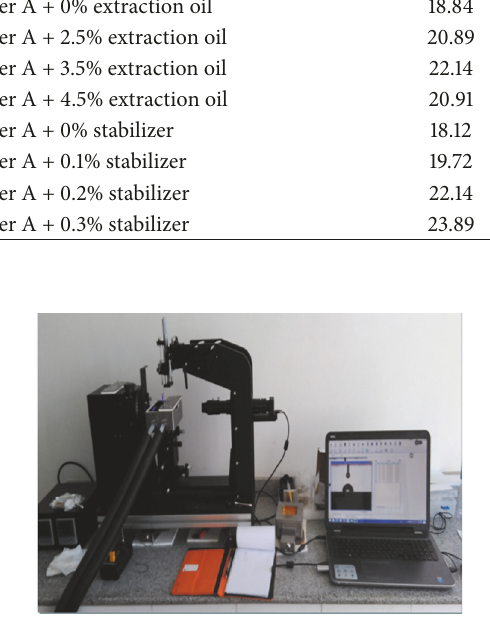
Figure 4: Drop shape